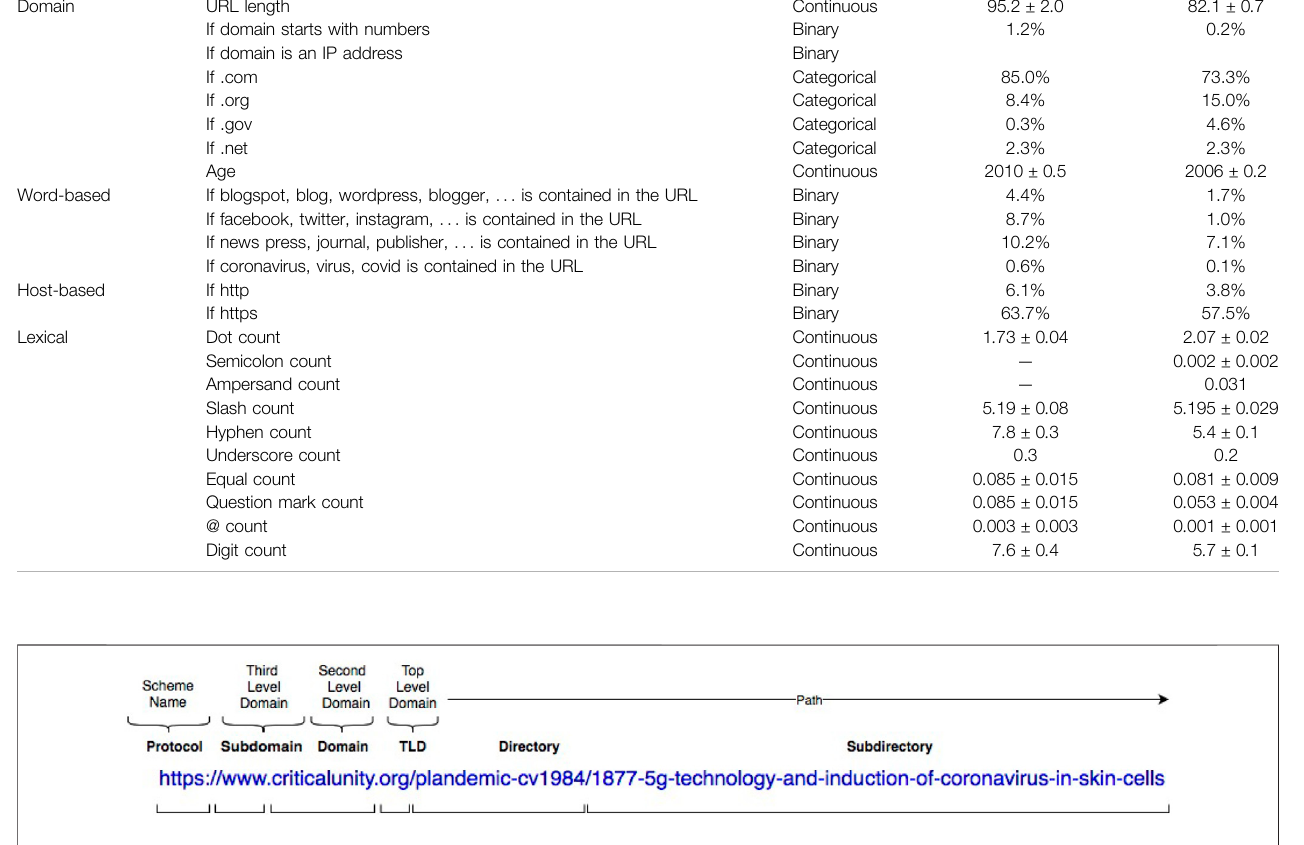
Frontiers in Physics |